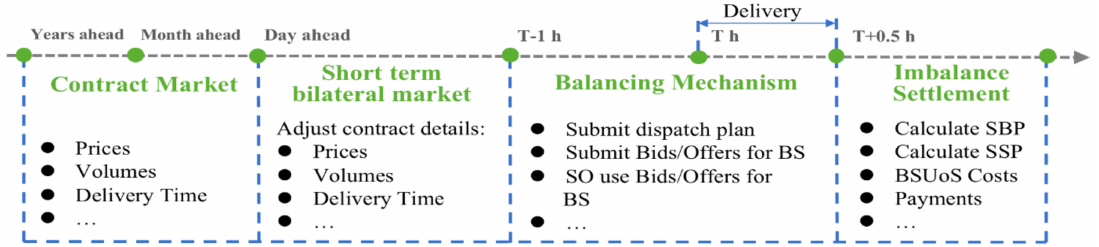
Figure 5. The transaction process of British Electricity Trading, and Transmission Agreements